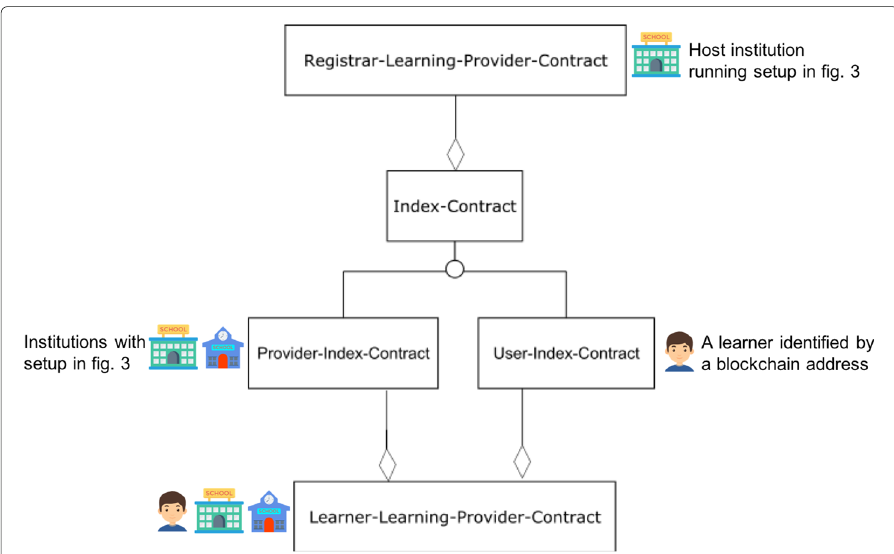
Fig. 4 Hierarchical view of BOLL system smart contracts. This figure shows the top-level design of the BOLL system’s smart contracts. The smart contracts control how institutions join the blockchain, how learning records are written, indexed, or accessed. The smart contracts also contain information on how permissions can be granted at various